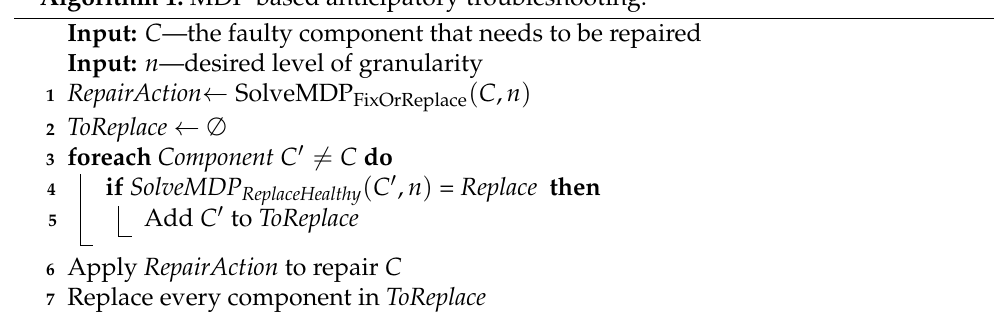
Algorithm 1: MDP-based anticipatory